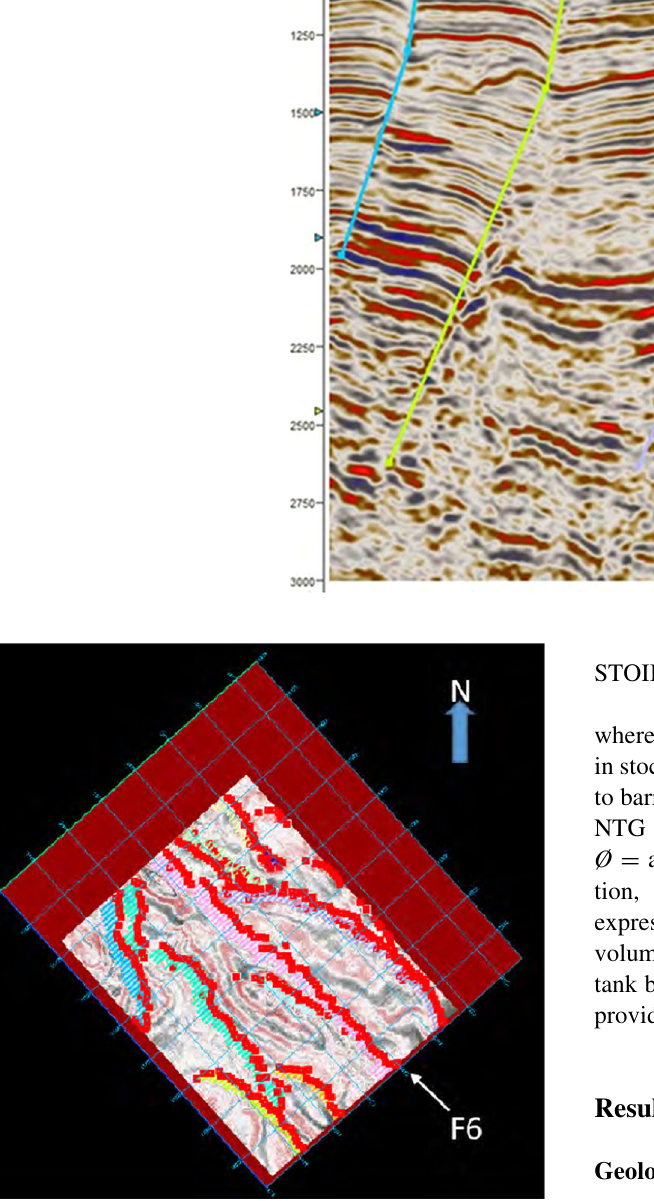
Fig. 5 Structural interpretation of ‘SH’ field showing Inline 11,586. It reveals antithetic faults (F4 and F8) and counter- regional faults (F10 and F14)